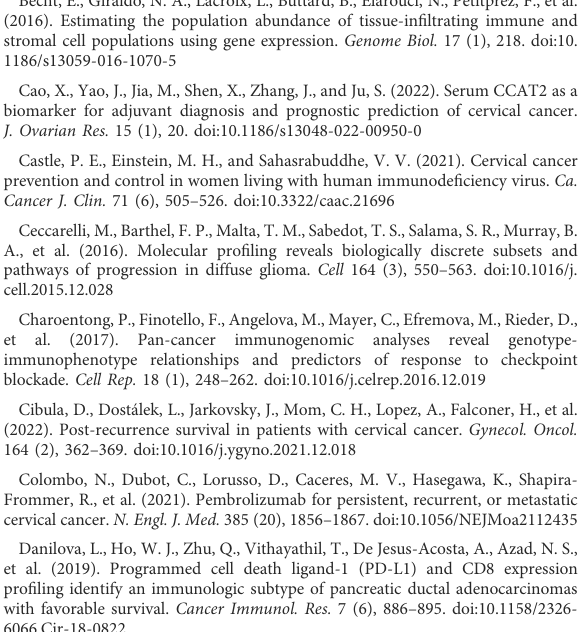
SUPPLEMENTARY TABLE S4 The demographics and follow-up information of the IMvigor210 cohort. SUPPLEMENTARY TABLE S5 The information of DEGs between IC1 and IC2 immune subtypes in the TCGA dataset. SUPPLEMENTARY TABLE S6 The information of DEGs between IC1 and IC2 immune subtypes in the GSE44001